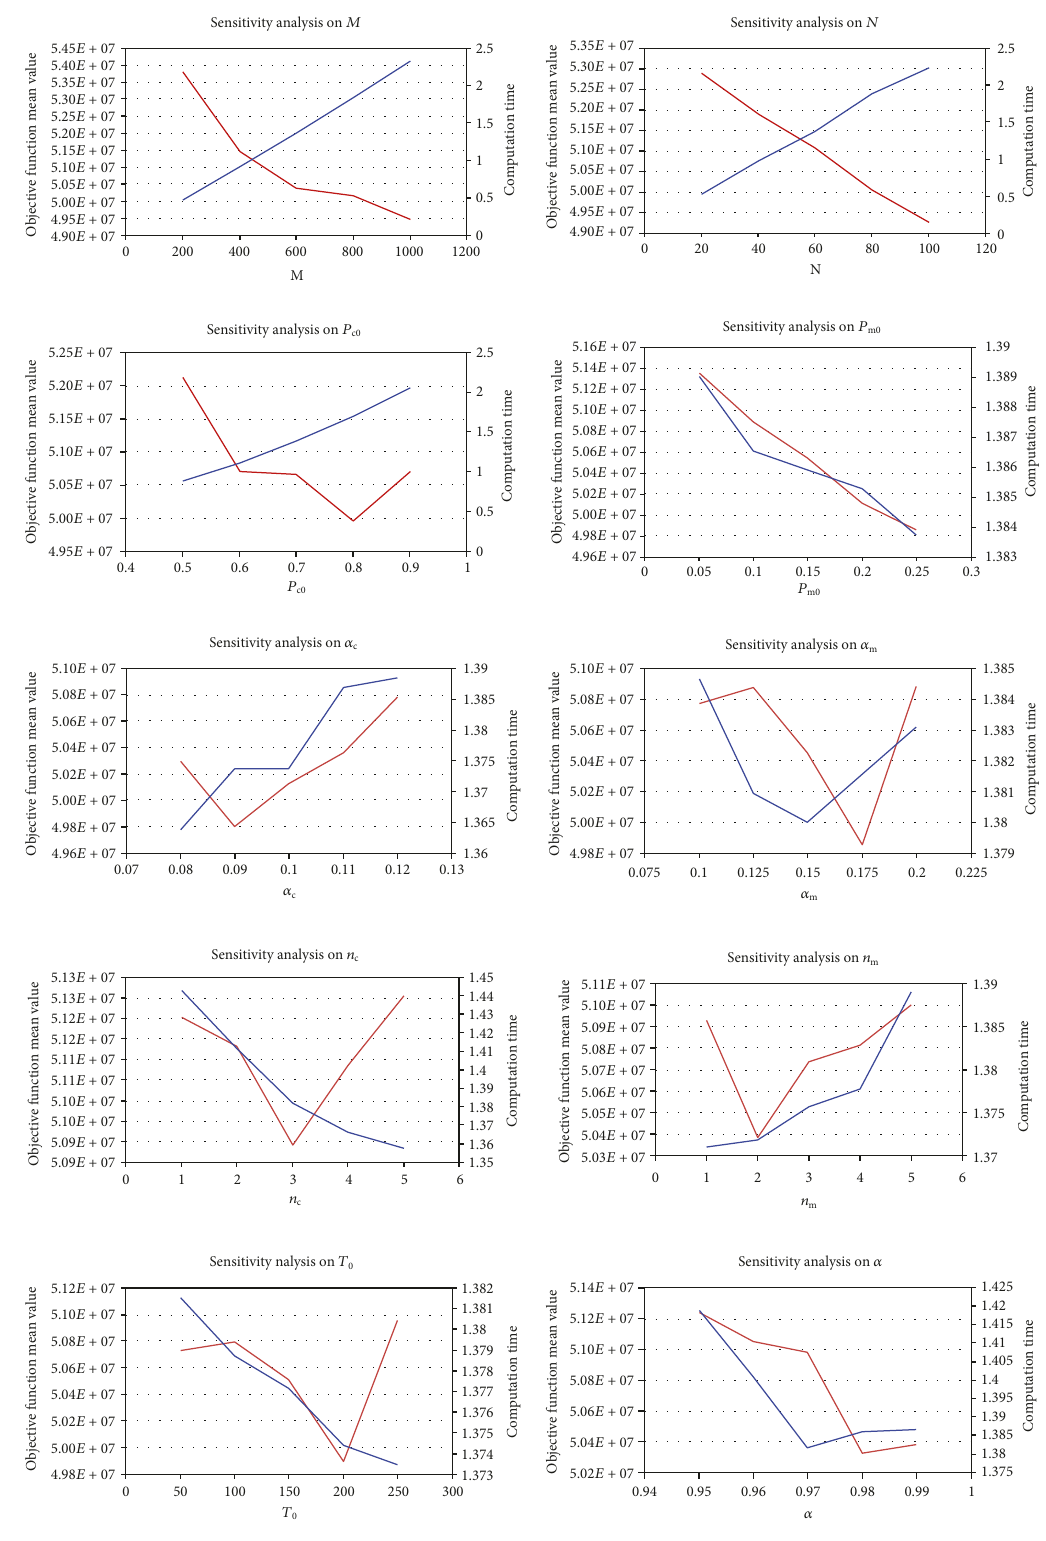
Figure 3: Sensitivity analysis on AHSAGA